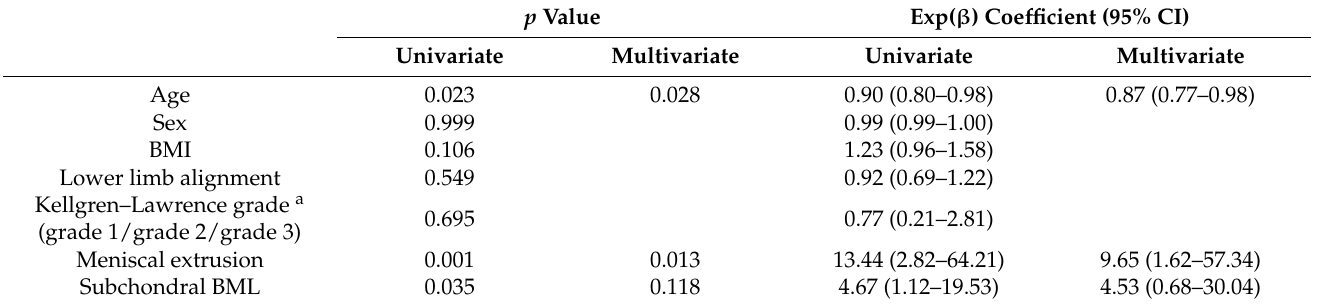
Table 2. Logistic regression analyses regarding unstable flap.